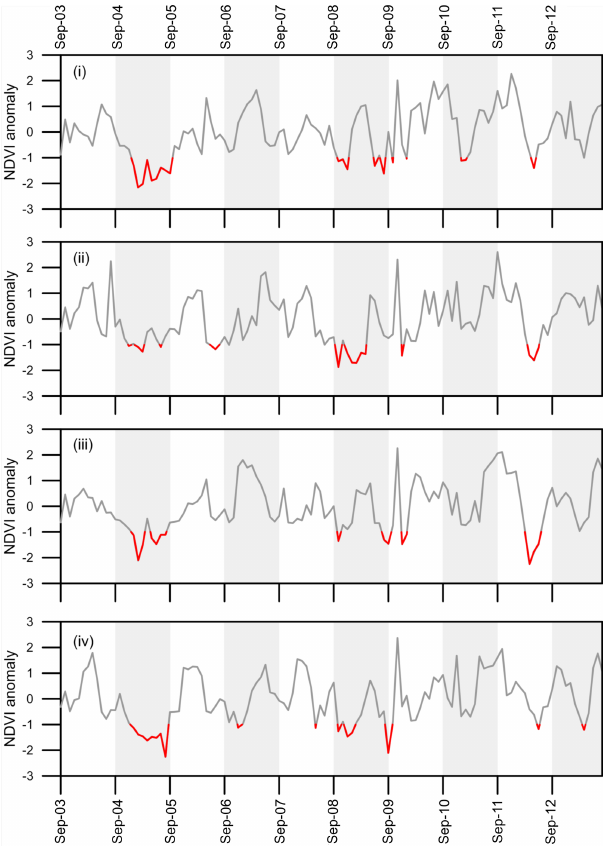
Figure 5. Variation of the monthly NDVI anomaly for the four se- lected locations within the region “La Campiña” over the study pe- riod. Red lines indicate values below the defined threshold of −